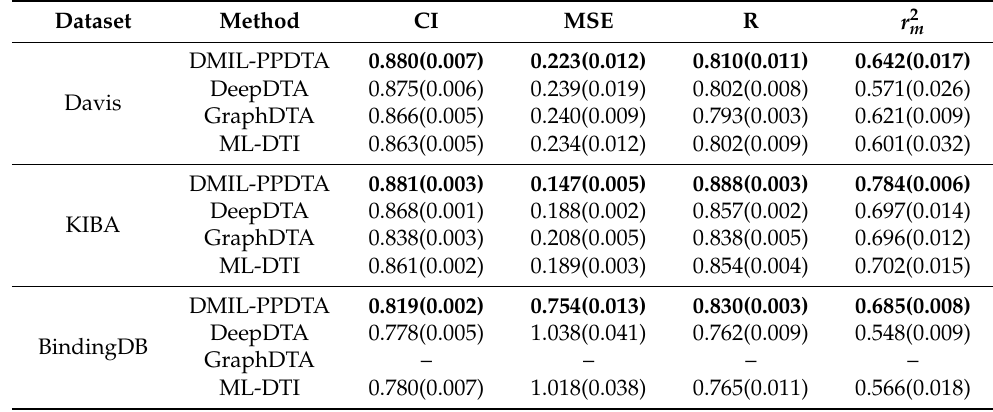
Figure 1. The overlap between drugs and targets in the KIBA dataset. ( a ) drug overlap under the random setting; ( b ) target overlap under the random setting; ( c ) drug overlap under the blind setting; ( d ) targets overlap under the blind setting. Table 2. Comparison among the results obtained by the DMIL-PPDTA approach and the baseline methods across the datasets under the random splitting setting. The entries in boldface denote the best result for each metric, and the data in brackets represent standard